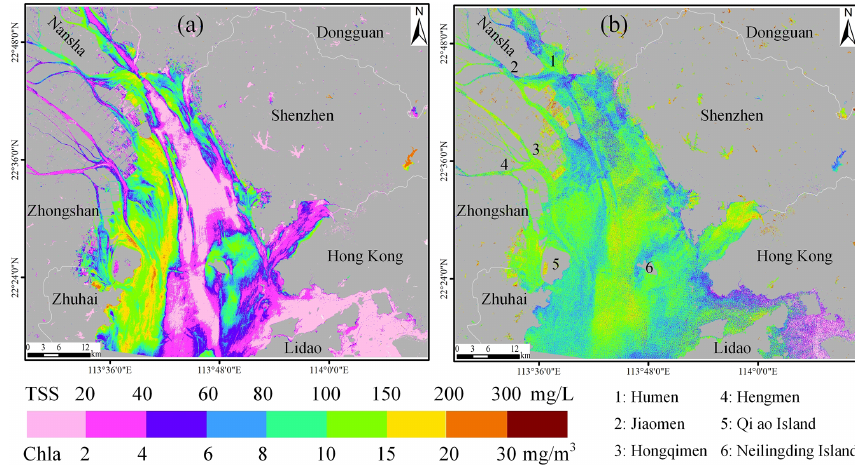
Figure 4. The estimated TSS concentrations (a) and Chl a concentrations (b) in the PRE on 20 November